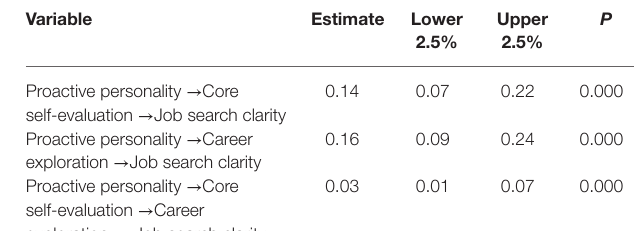
TABLE 3 | Bootstrapping regression results for proactive personality mediated by core self-evaluation and career exploration. ( N = 495).